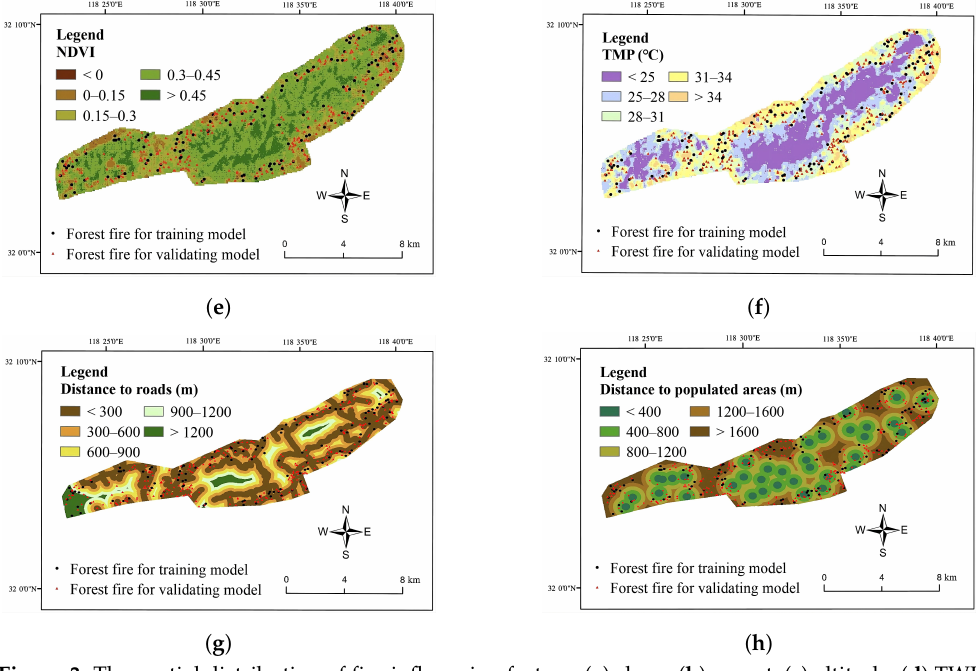
Figure 3. The spatial distribution of fire-influencing factors: ( a ) slope; ( b ) aspect; ( c ) altitude; ( d ) TWI;